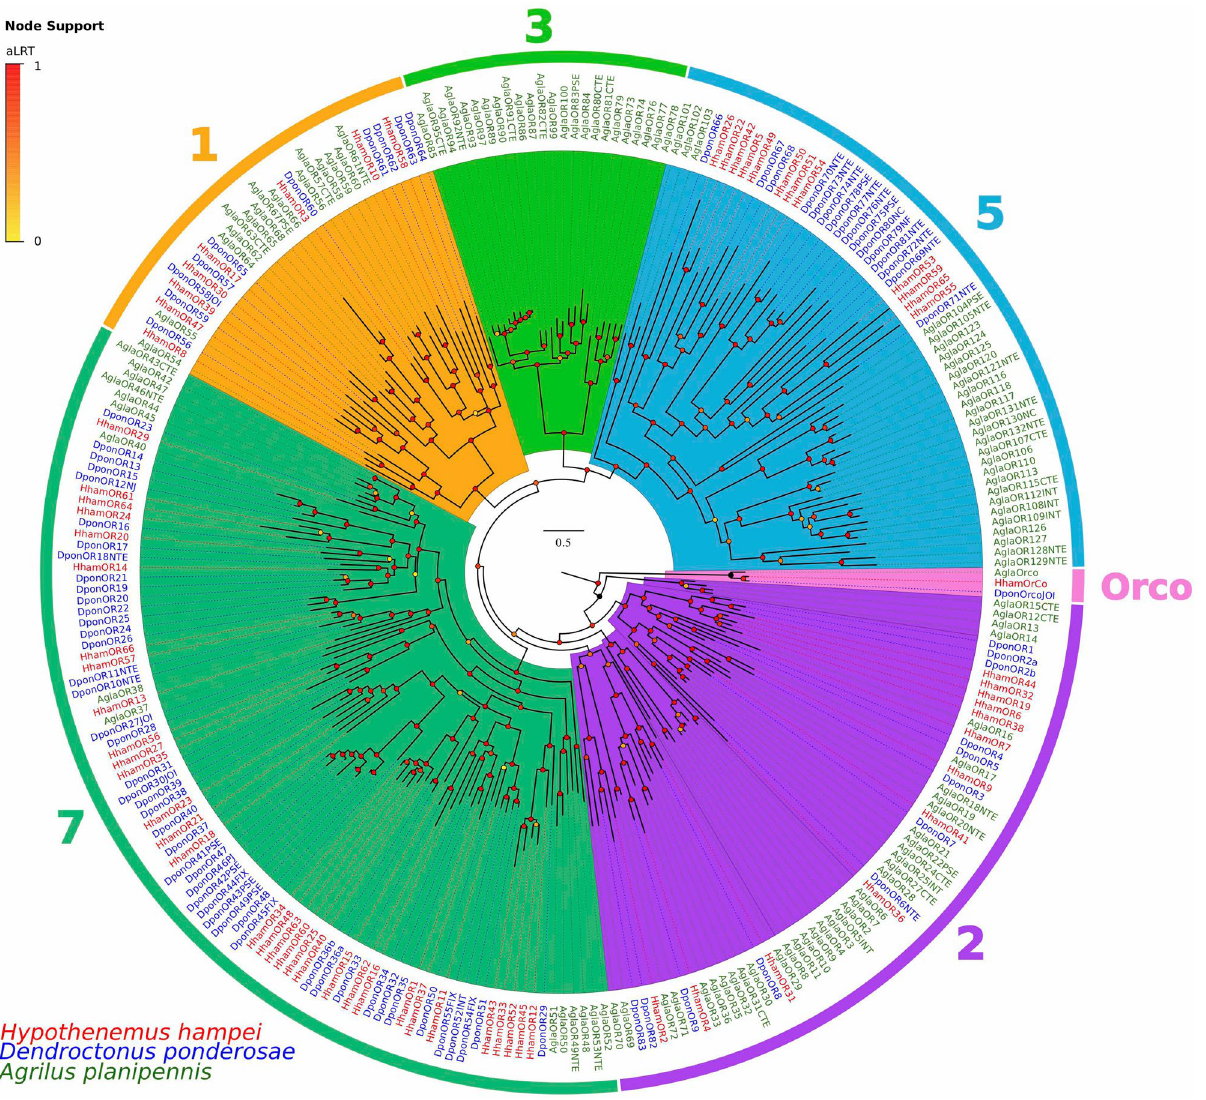
Figure 2. Phylogeny of odorant receptor (OR) family. OR protein sequences from Hypothenemus hampei (HhamOR), Dendroctonus ponderosae (DponOR) and Agrilus planipennis (AplaOR) were clustered by Maximum-Likelihood tree-building. Branch supports (aLRT; approximate likelihood ratio test) are shown as colored circles (yellow to red transition). Colored arcs indicate the clusters for OR families 1–3, 5 and 7; and the conserved OR coreceptor (Orco)